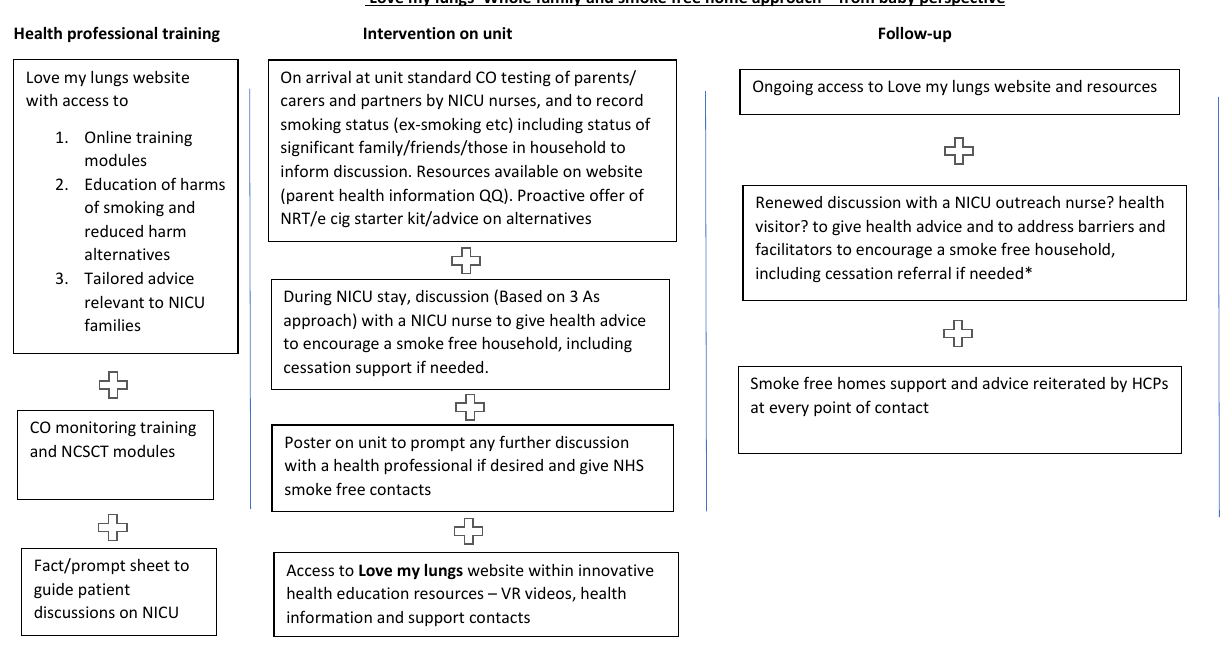
Figure 2. Intervention